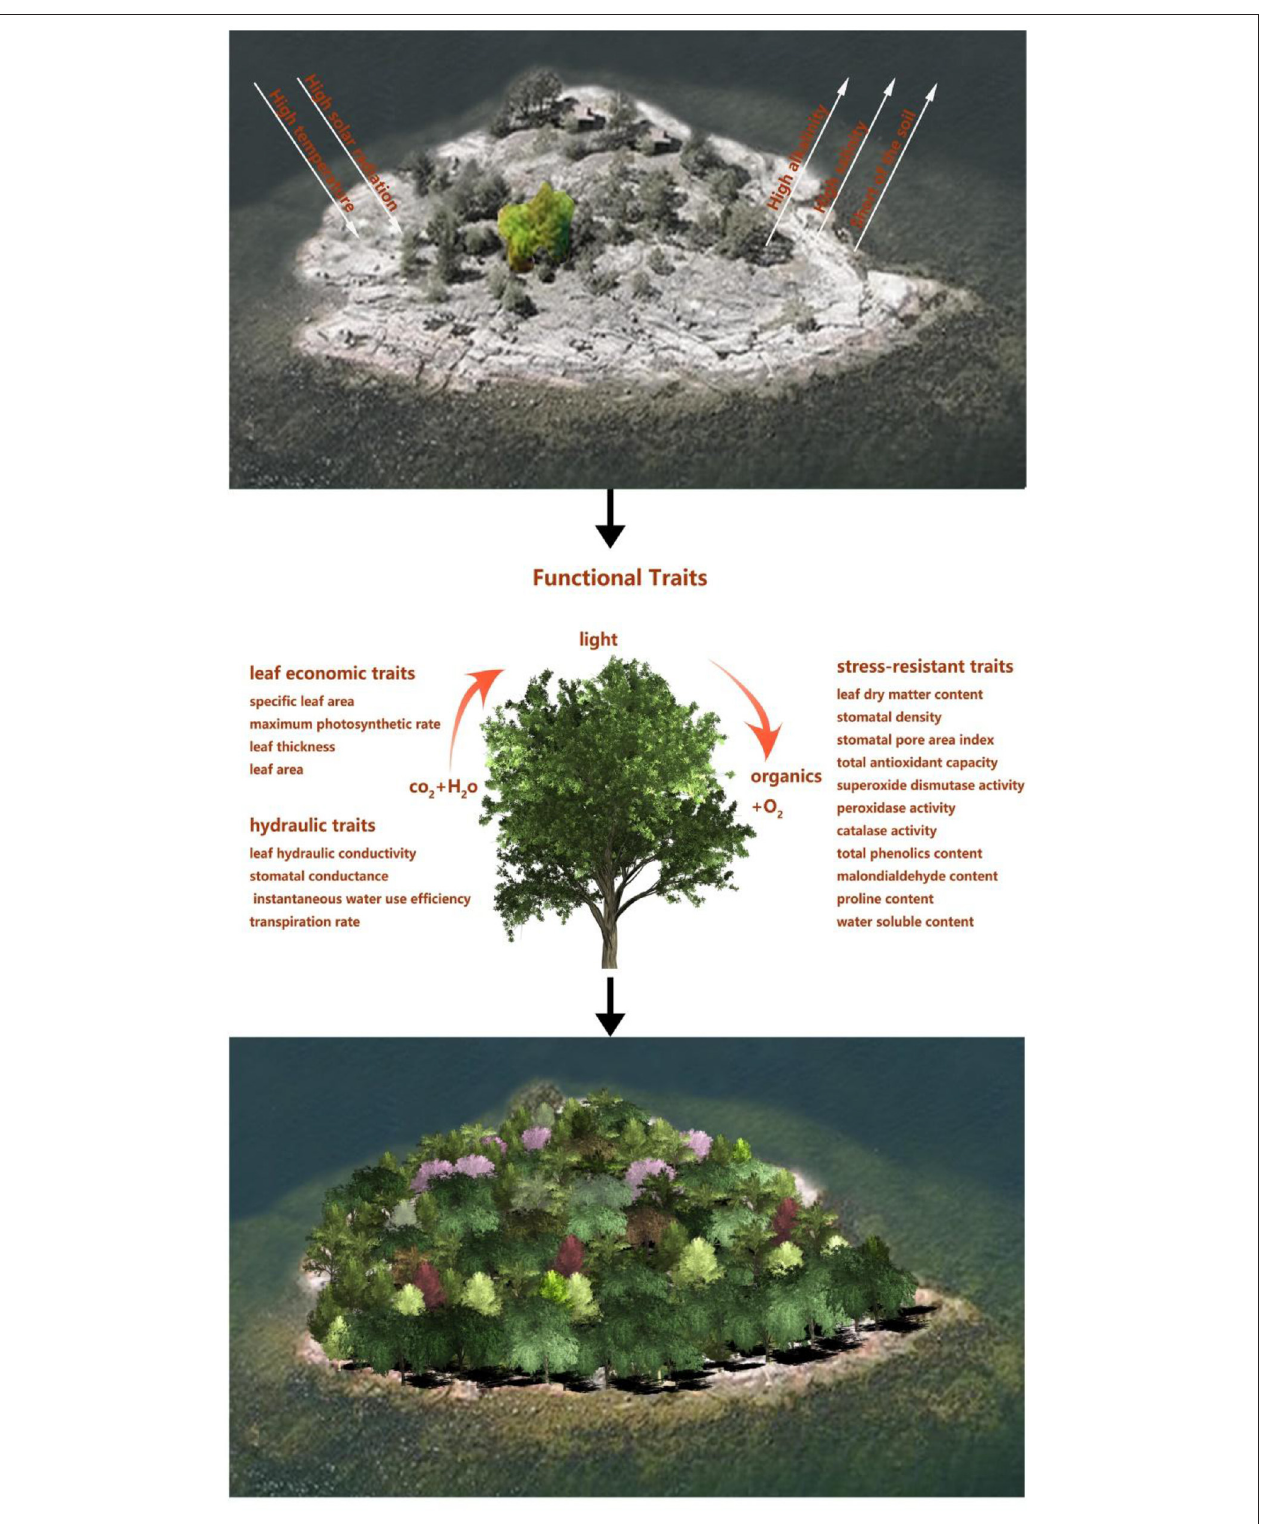
FIGURE 1 | A successful example for describing how to use the trait-based protocol developed by Wang et al. to quickly and effectively select many suitable native tree species to successfully restore an extremely degraded tropical coral island to tropical forest.